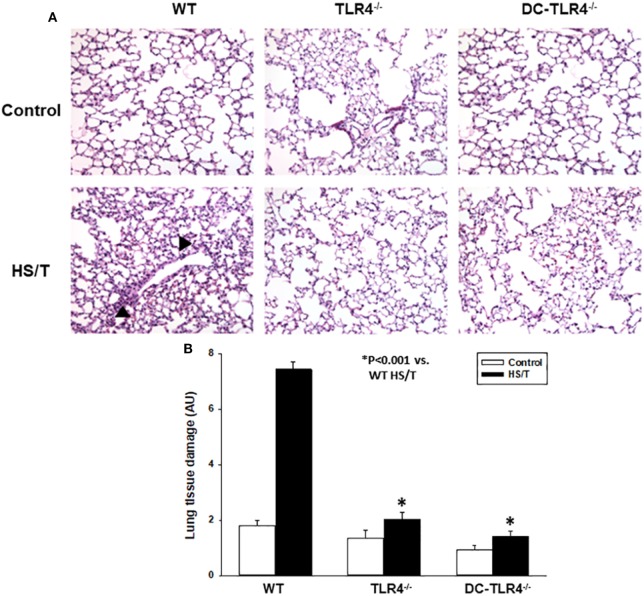
Histopathological analysis of lung in experimental bone marrow (BM) chimeras after HS/T. Lung sections from wild-type (WT) and experimental BM chimeras [TLR4−/− and dendritic cell (DC)-TLR4−/−], left untreated (control) or 6 h after HS/T were stained with H&E (A) as described in Section “Materials and Methods.” Images are representative of 7–10 mice per treatment group. Arrow heads point to inflammatory cell infiltration in the lung. Panel (B) shows the quantification of organ damage (*P < 0.001, analyzed by Student’s t-test).